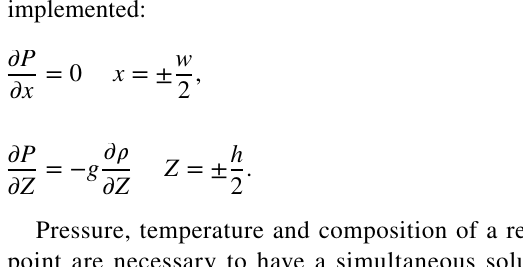
Table 1 Gas condensate sample, reference point values, reported